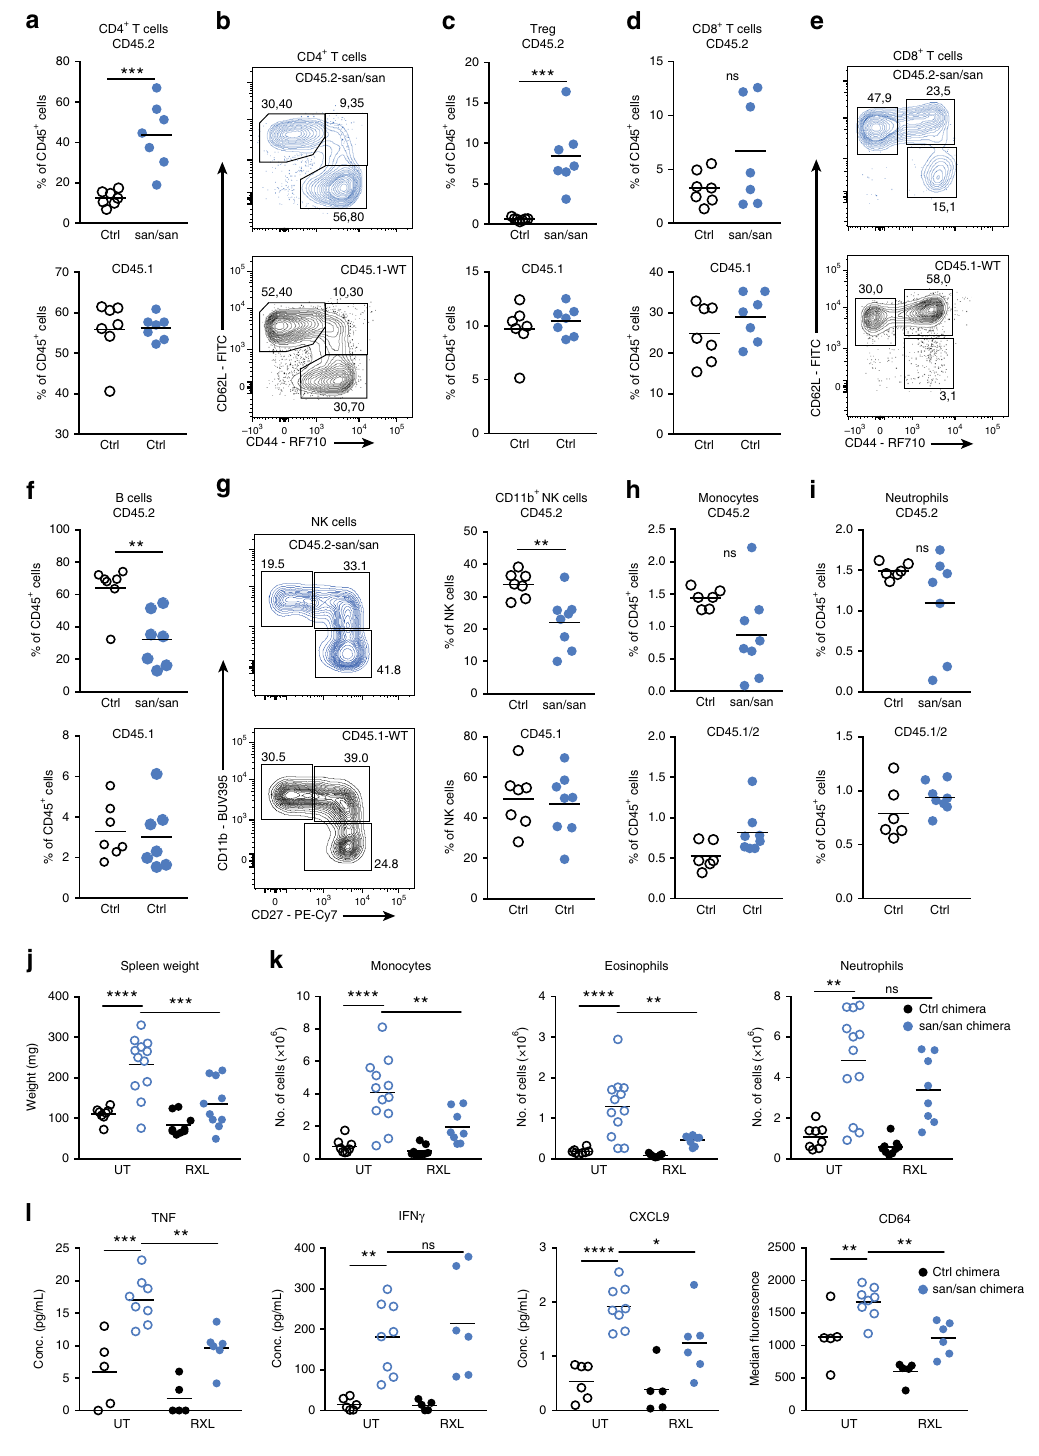
levels of the R687* or 1-509AA variants (Fig. 7c). Expression of Ox40 and CTLA4 were not repressed by the R687* and 1-509AA variants whereas the M199R mutation reduced both surface proteins to a similar extent as WT Roquin-1 (Fig. 7d, e). Similar observations were made for c-Rel (Supplementary Fig 7C). These data indicate that the M199R and R687* variants represent hypomorphic mutations but have diverging effects on speci fi